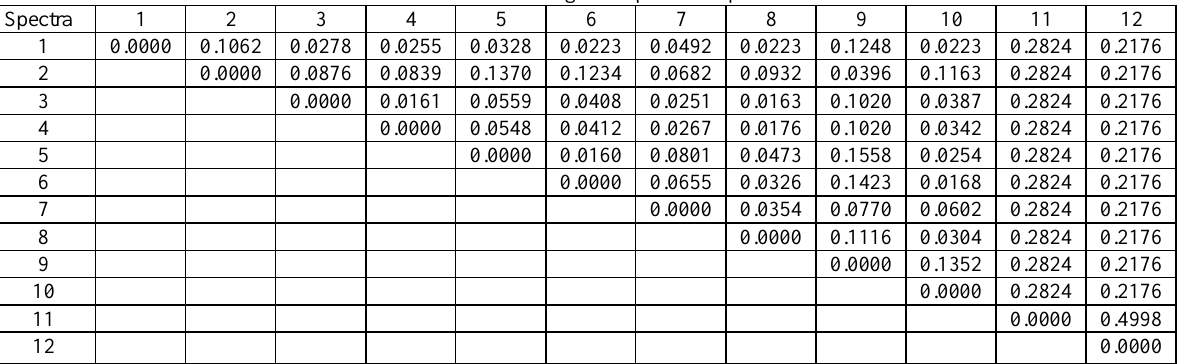
Table 5: CBD among Chickpea field spectra